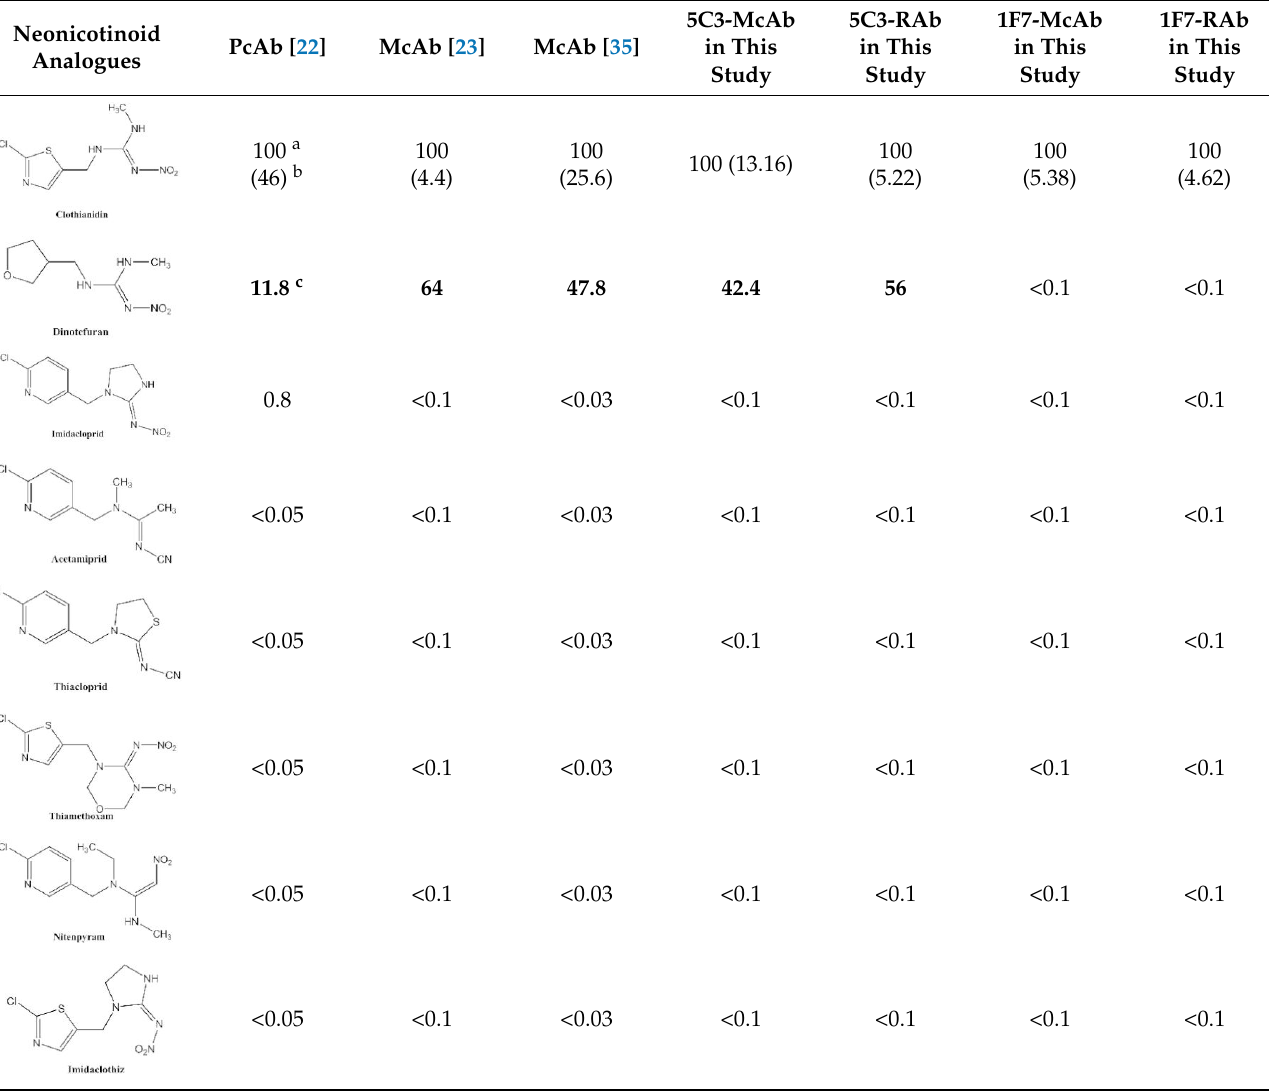
Table 1. Comparison of the cross-reactivity of anti-clothianidin antibodies with other previously reported antibodies by ic-ELISAs